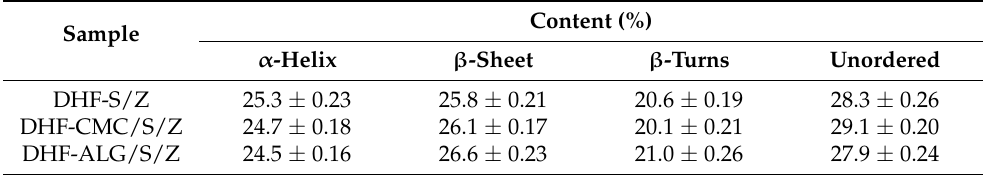
Table 2. Secondary structure of zein in DHF-S/Z, DHF-CMC/S/Z and DHF-ALG/S/Z.